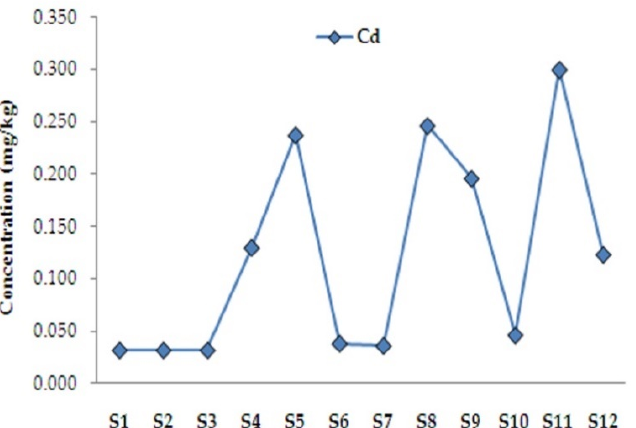
Figure 2. Distribution of Cd within the samples; cocoa content: S1 —40% with pepper, S2 —49%, S3 —56%, S4 —73%, S5 —75%, S6 —75% with orange, S7 —75% with raspberry, S8 —77%, S9 —77% with orange, S10 —85% (gluten-free, no added sugar), S11 —88%, S12 —99%; ( n = 3).